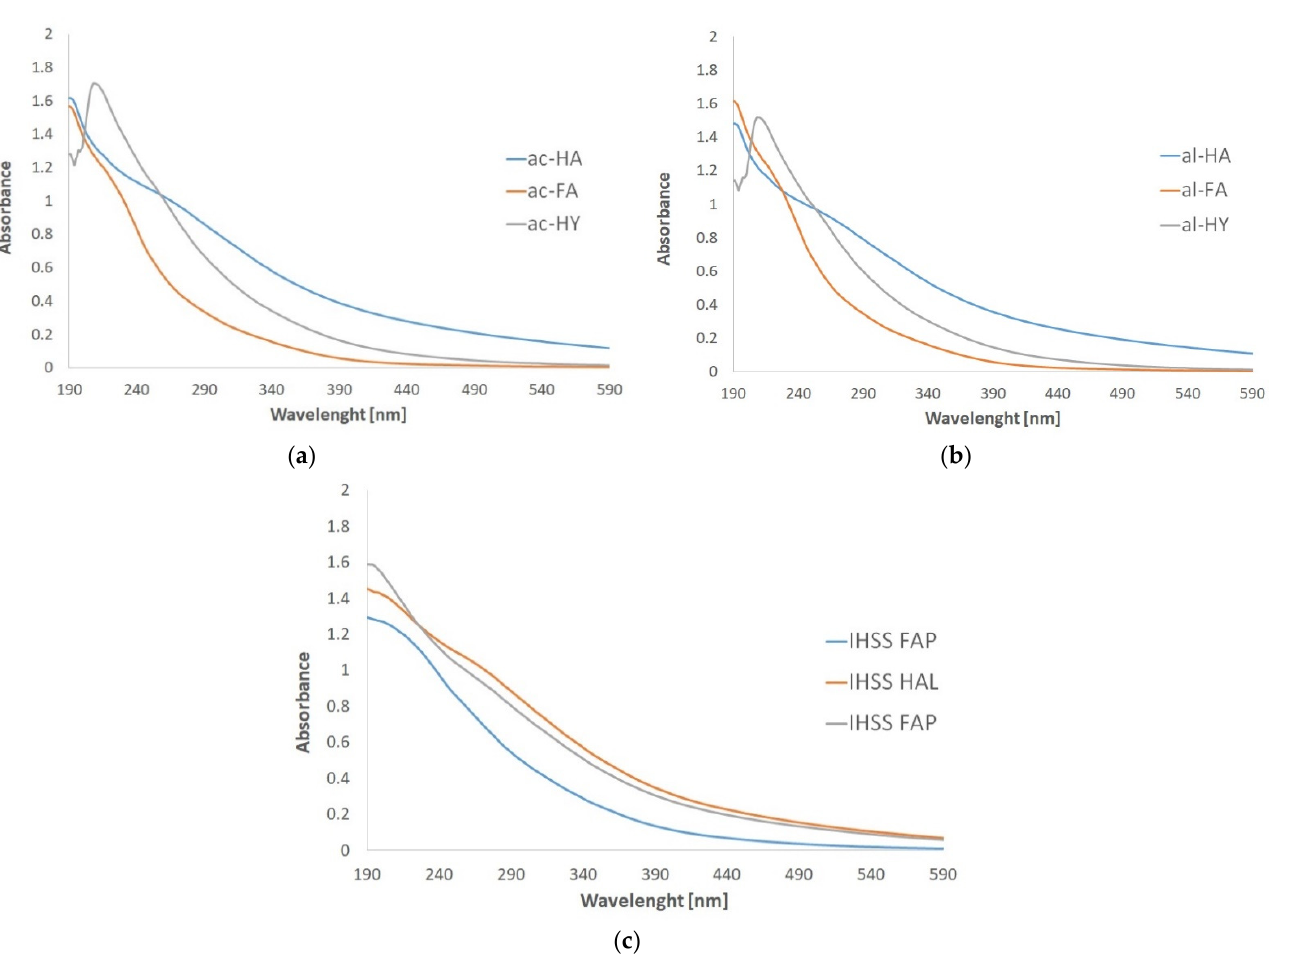
Figure 2. UV–Vis spectra of the different HS fractions from leonardite for comparison with IHSS samples: ( a ) the acid extracted fractions, ( b ) the fractions from alkaline extraction, ( c ) the IHSS standard samples. Table 3. Spectrophotometric indicators calculated as the ratio of absorbance values at different wavelengths of HS fractions from leonardite for comparison with IHSS